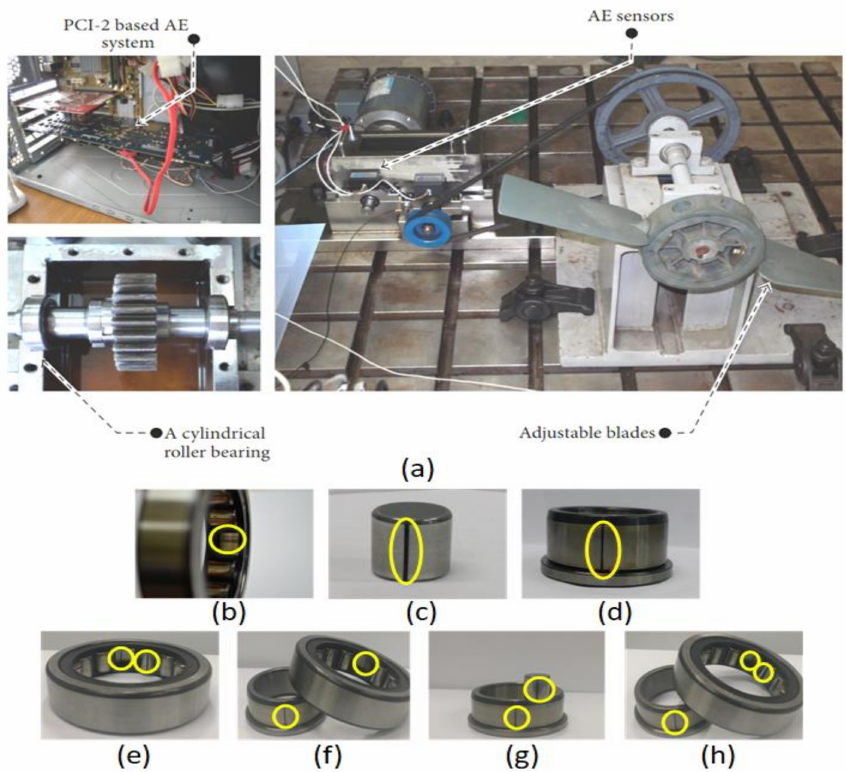
Figure 6. ( a ) Data acquisition system setup and the types of bearing defects: ( b ) BCO (outer raceway); ( c ) BCR (roller element); ( d ) BCI (outer raceway); ( e ) BCOR (outer–roller defect); ( f ) BCOI (outer–inner defect); ( g ) BCIR (inner–roller defect); ( h ) BCOIR (outer–inner roller defect)